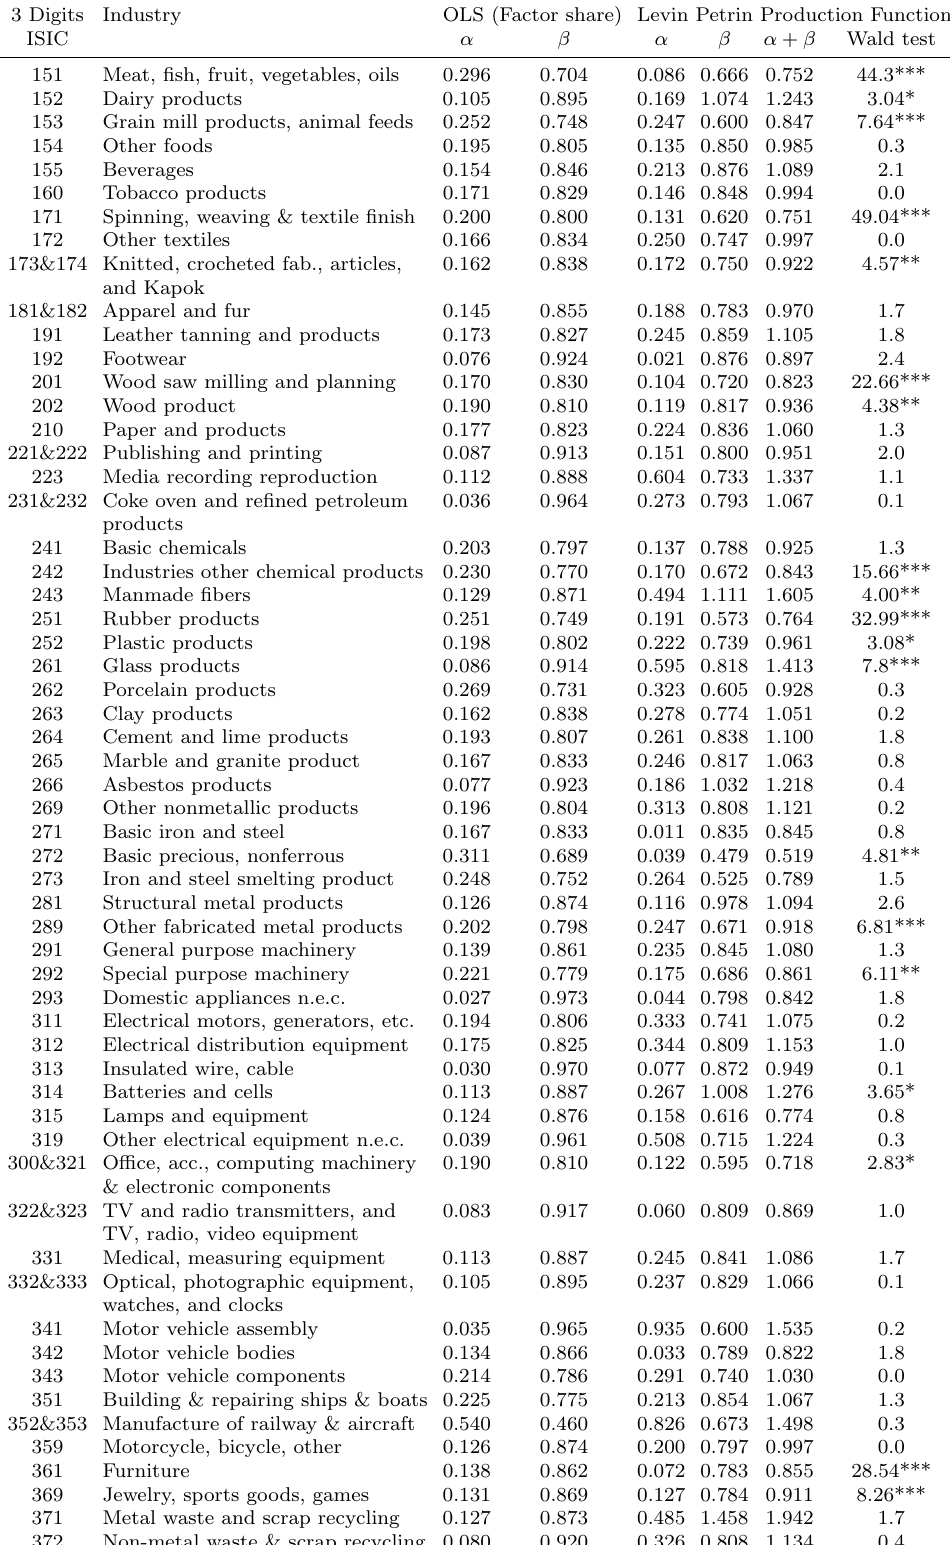
Table A.4: Plant-Level Production Function